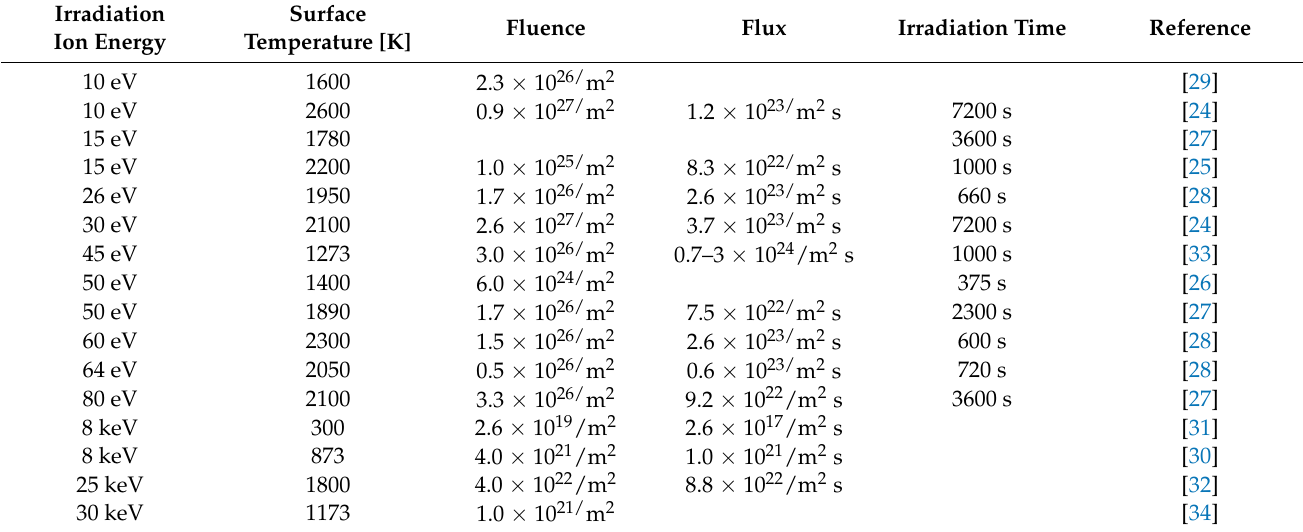
Table 1. Information on the He/D irradiation conditions used for the fractal analysis in the present study.